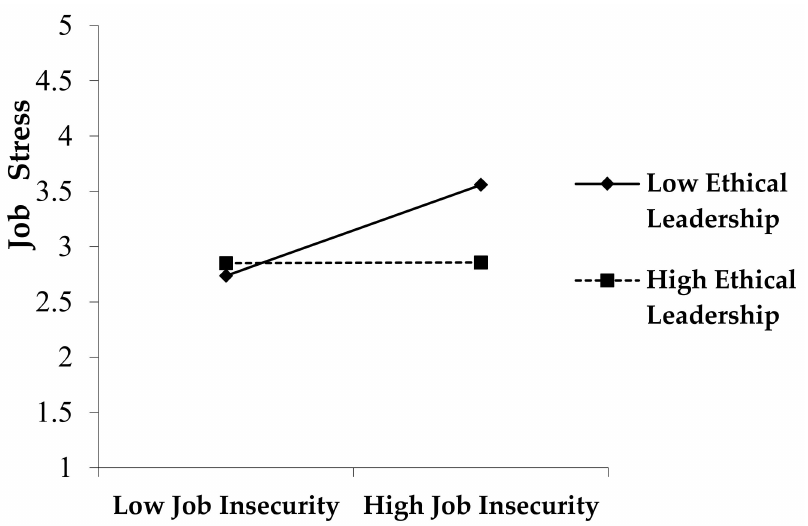
Figure 3. Moderating E ff ect of Ethical Leadership in the Job insecurity–Job Stress